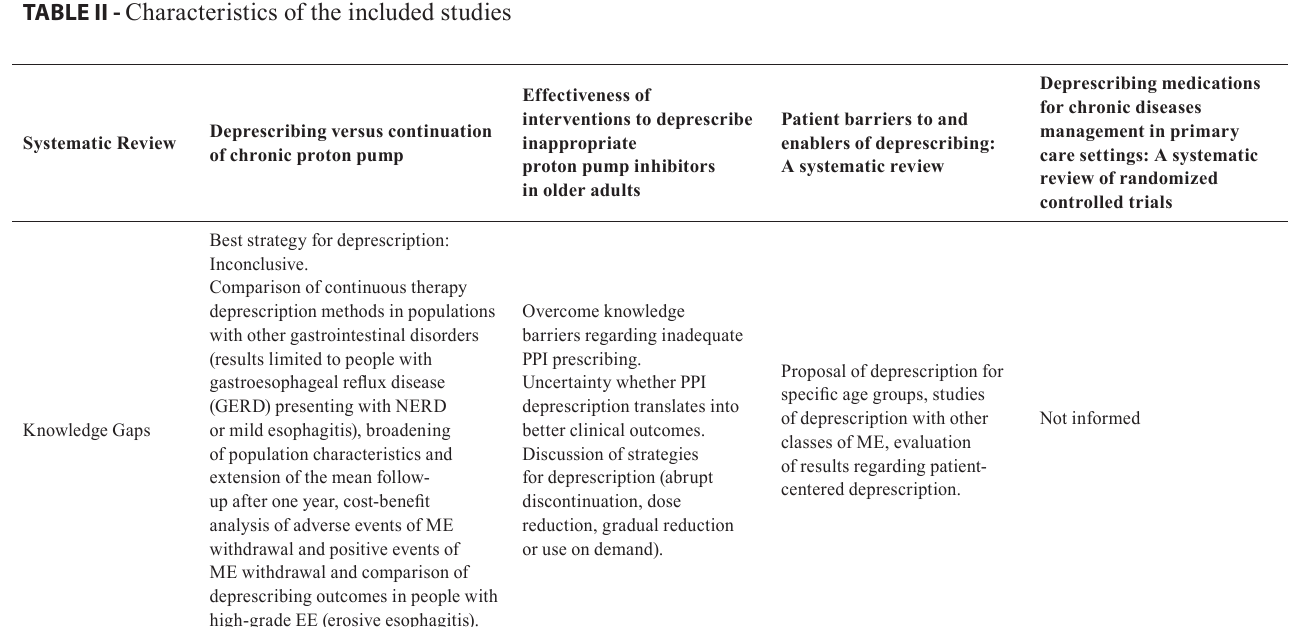
TABLE II - Characteristics of the included studies